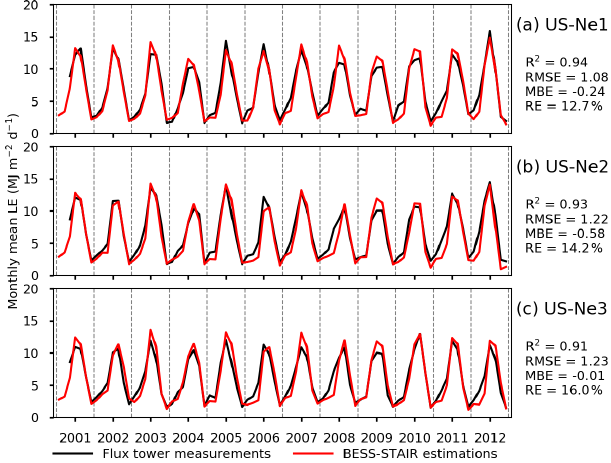
Figure A1. Time series of monthly mean ET from flux-tower mea- surements and BESS-STAIR estimations.